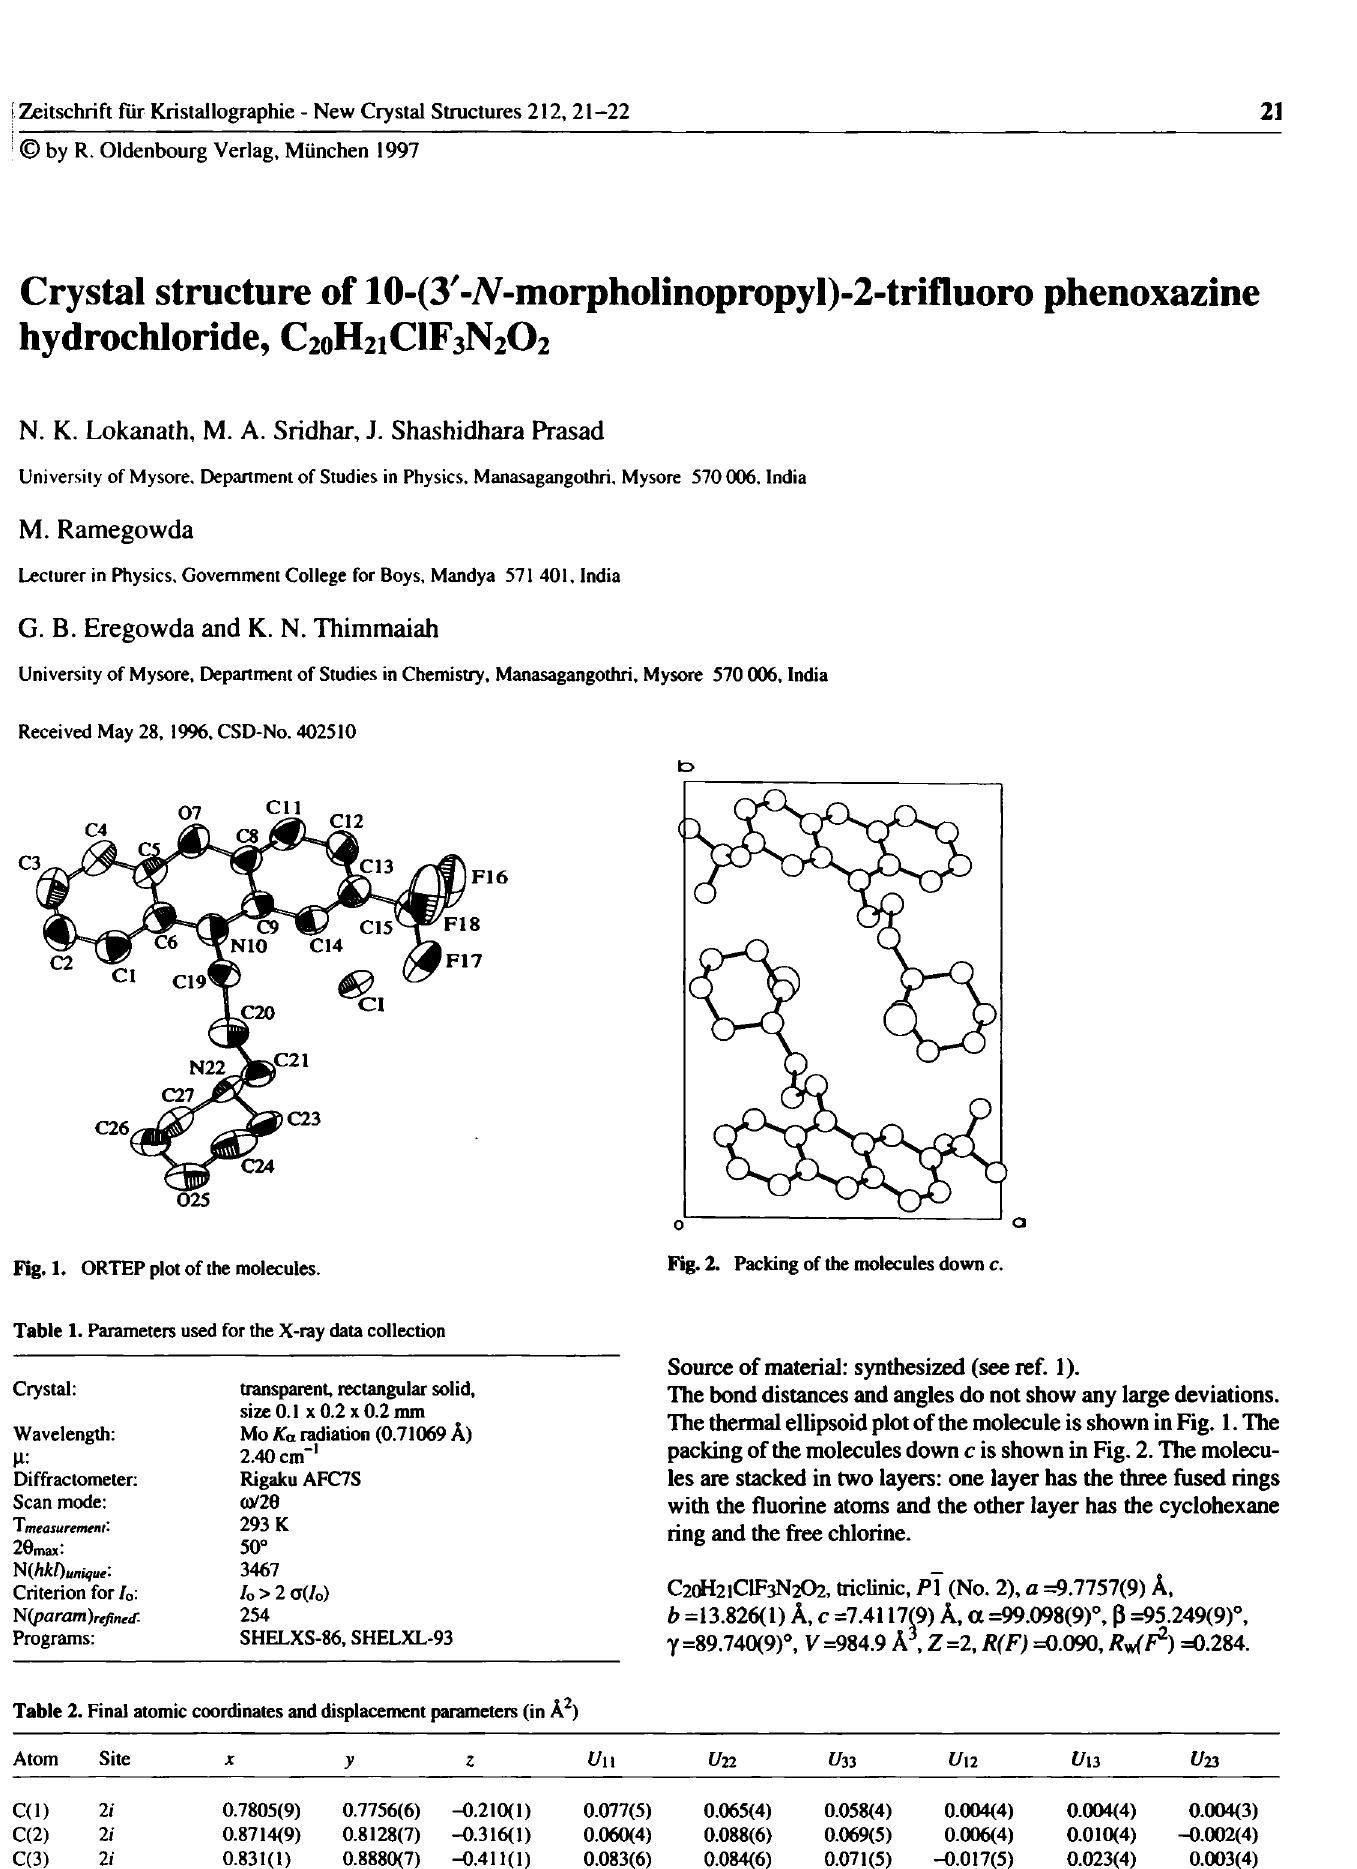
Table 2. Final atomic coordinates and displacement parameters (in Â 2